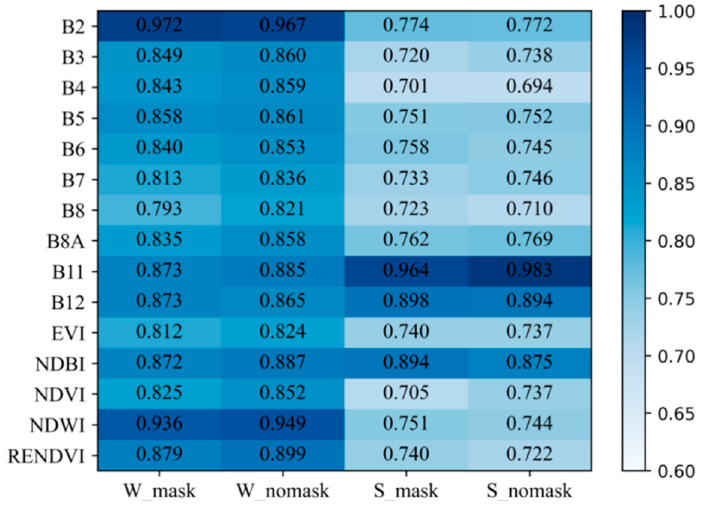
Figure 6. The feature importance under different conditions. W_mask and S_mask were the results in winter and summer with cultivated land as a mask, respectively, while W_nomask and S_nomask are the results in winter and summer without cultivated land as a mask, respectively.